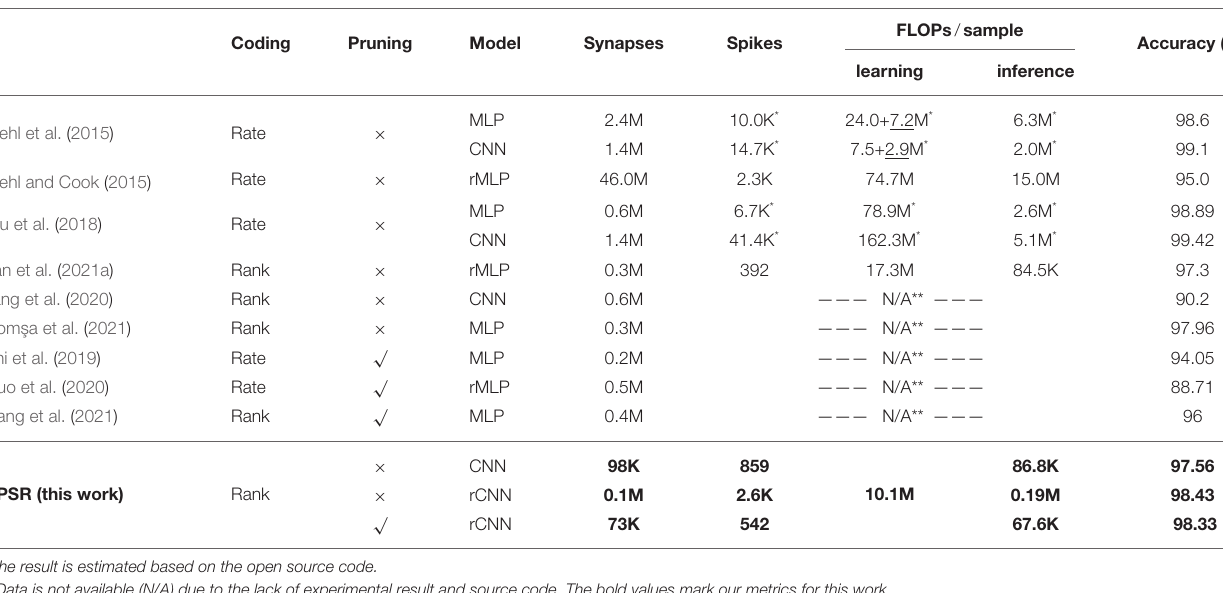
TABLE 3 | Comparison of different spiking models on MNIST dataset.